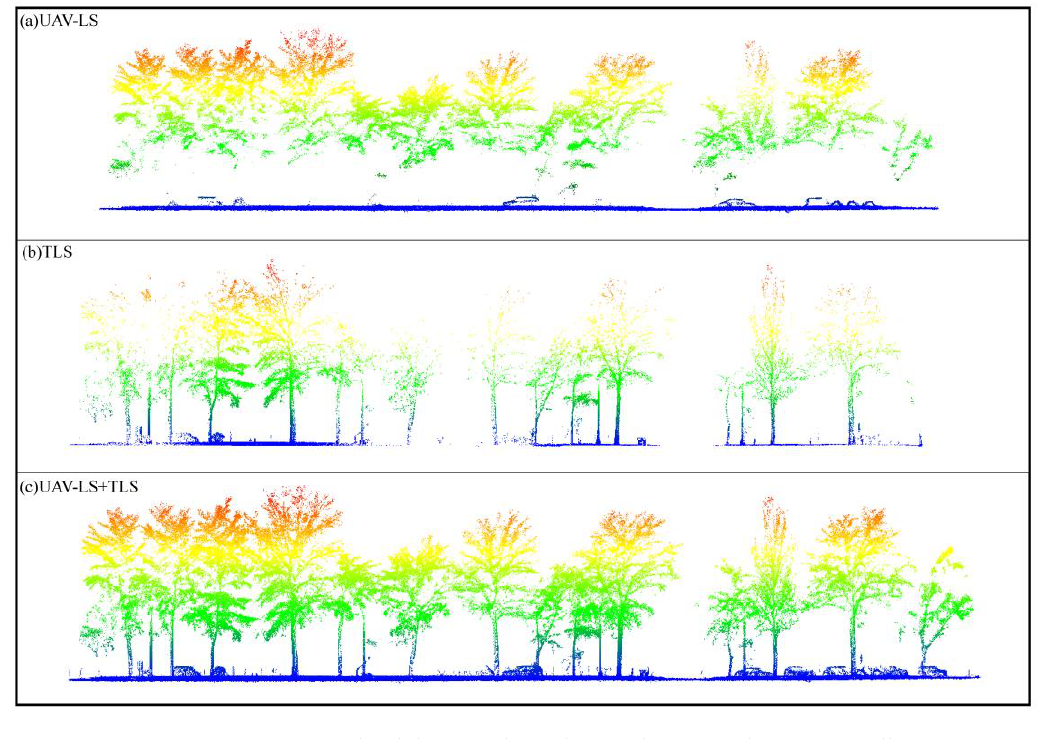
Figure 5. Point cloud data graph combining the TLS and UAV-TLS collections.